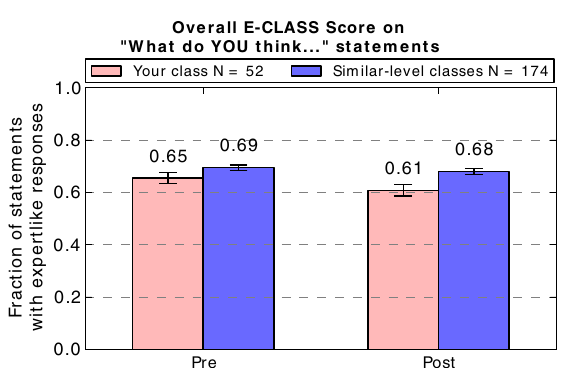
FIG. 5. Comparison between overall pre and post scores for students ’ personal views about “ What do YOU think when doing experiments for class? ” Your class (red) is compared with all students in similar-level classes (i.e., introductory calculus-based physics classes) (blue). The error bars show 95% confidence intervals. The overall mean shown here averages over all students and all statements on the survey.